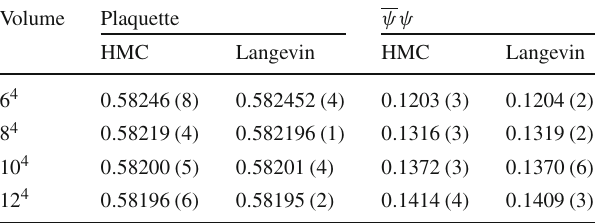
Table 2 Average values for the plaquette and chiral condensate from simulations of four flavours of naïve staggered fermions at β = 5 . 6, m = 0 . 025 and μ = 0. The Langevin results have been obtained after extrapolation to zero step size